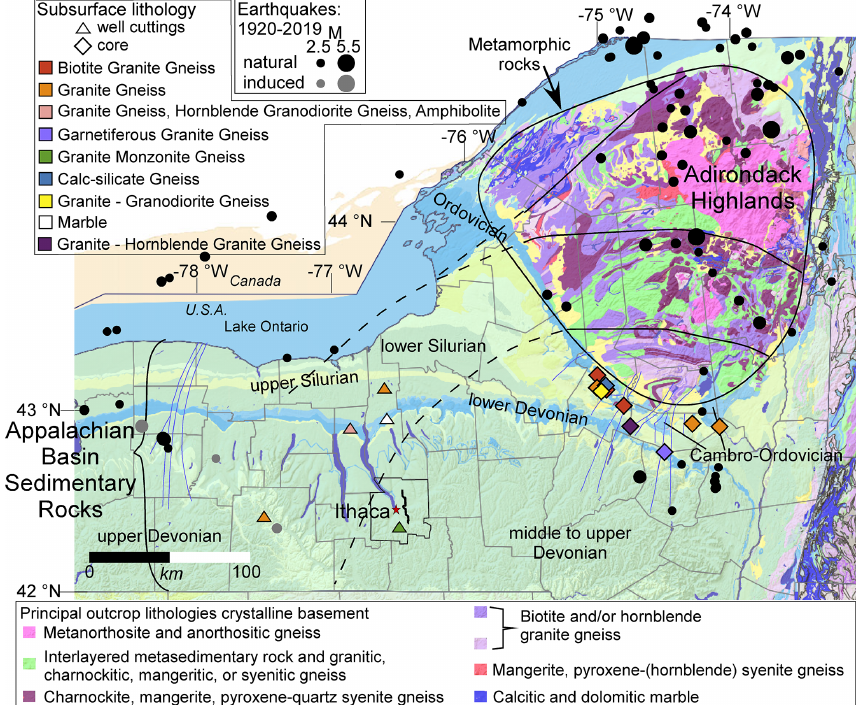
Figure 1. Map of geology and historical earthquakes in New York State. Geological map shows bedrock composition immediately sub- jacent to soil and Holocene sediments (USGS map source, https://mrdata.usgs.gov/geology/state/map.html?x=-75.6897884252848&y=42. 9882351360762&z=7#, last access: 20 November 2020). The Adirondack Mountains in northern New York are enclosed in a subcircular black polygon. For sedimentary rocks of the Appalachian Basin, the geological periods corresponding to some of the mapped colors are labeled on the map. Subsurface basement lithologies are known from petrographic analysis of samples of cores and cuttings that are archived by the New York State Museum (Benjamin R. Valentino, unpublished data, 2016). Positions of major shear zones of the Adirondack crys- talline rocks (solid black lines) are from Valentino et al. (2008) and Valentino and Chiarenzelli (2018). Projections of those shear zones beneath the Appalachian strata (dashed black lines) are based on Chiarenzelli and Valentino (2020). The set of blue lines in western New York is the Clarenden–Lynden fault zone, and the set of blue lines adjacent to the southern Adirondacks are faults that cut lower Ordovician, Cambrian and basement units (from Jacobi, 2002). Earthquakes are from USGS compilation span January 1920–20 January 2020 (USGS Earthquake Catalog, https://earthquake.usgs.gov/earthquakes/map/, last access: 20 November 2020; details of search listed among references cited). Induced earthquakes in western New York are attributable to brine mining-related work and to brine injection tests in an attempt to develop new caverns for gas storage (Smith et al., 2005; Horowitz et al., 2017). Polygon surrounding Ithaca delineates Tompkins County. A black line near Ithaca shows the location of a seismic reflection profile leased by Cornell to establish the distribution of faults and folds (Fig.